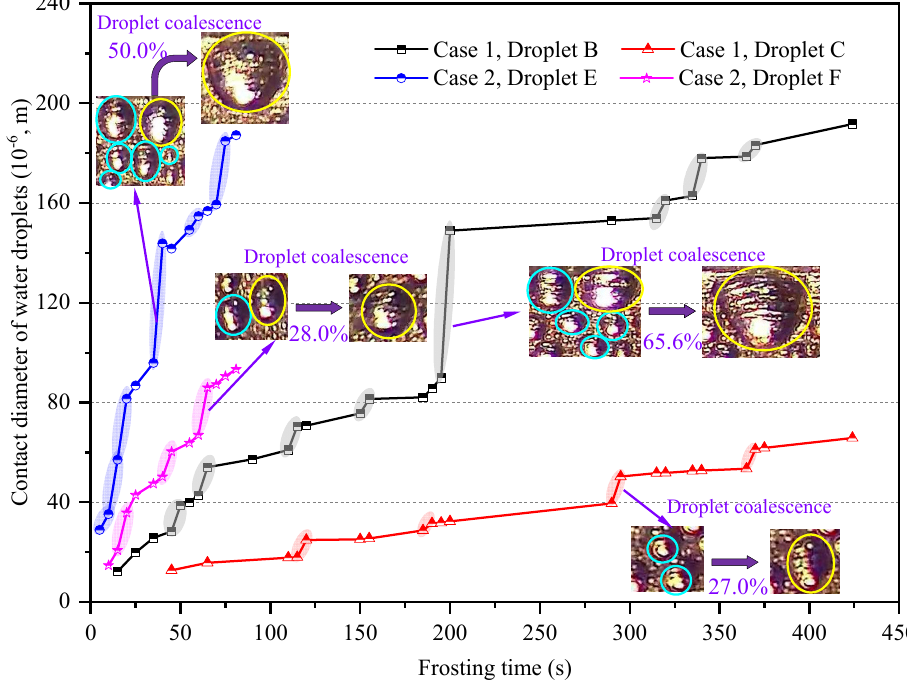
Figure 4. Characteristics of growth and coalescence of water droplets B, C, E, and F. As shown in Figure 4, the growing processes of Droplets B, C, E, and F were all coupled with droplet coalescence, as indicated by the shadows in the corresponding polygonal